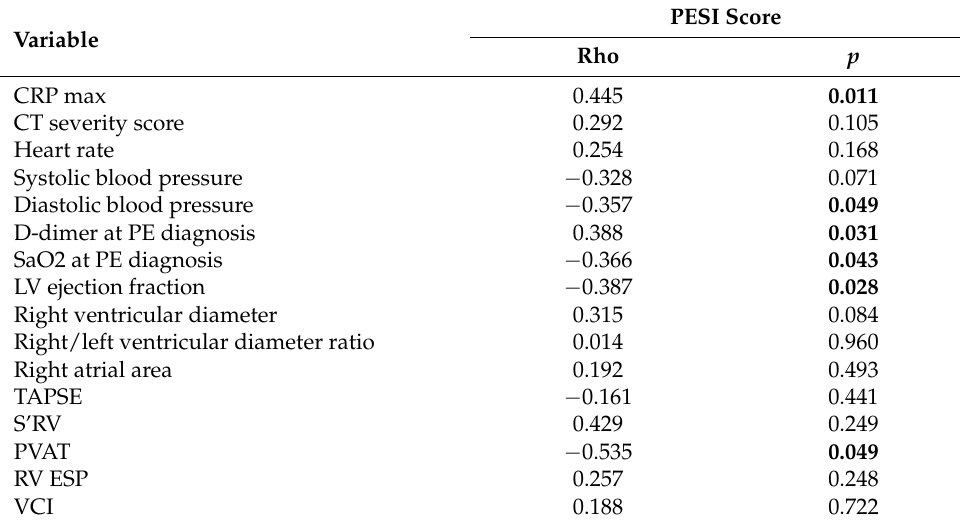
Table 7. Correlation of PESI score and characteristics of patients, clinical parameters, laboratory parameters, vital parameters at the time of pulmonary embolism diagnosis, and echocardiographic parameters of the study population.